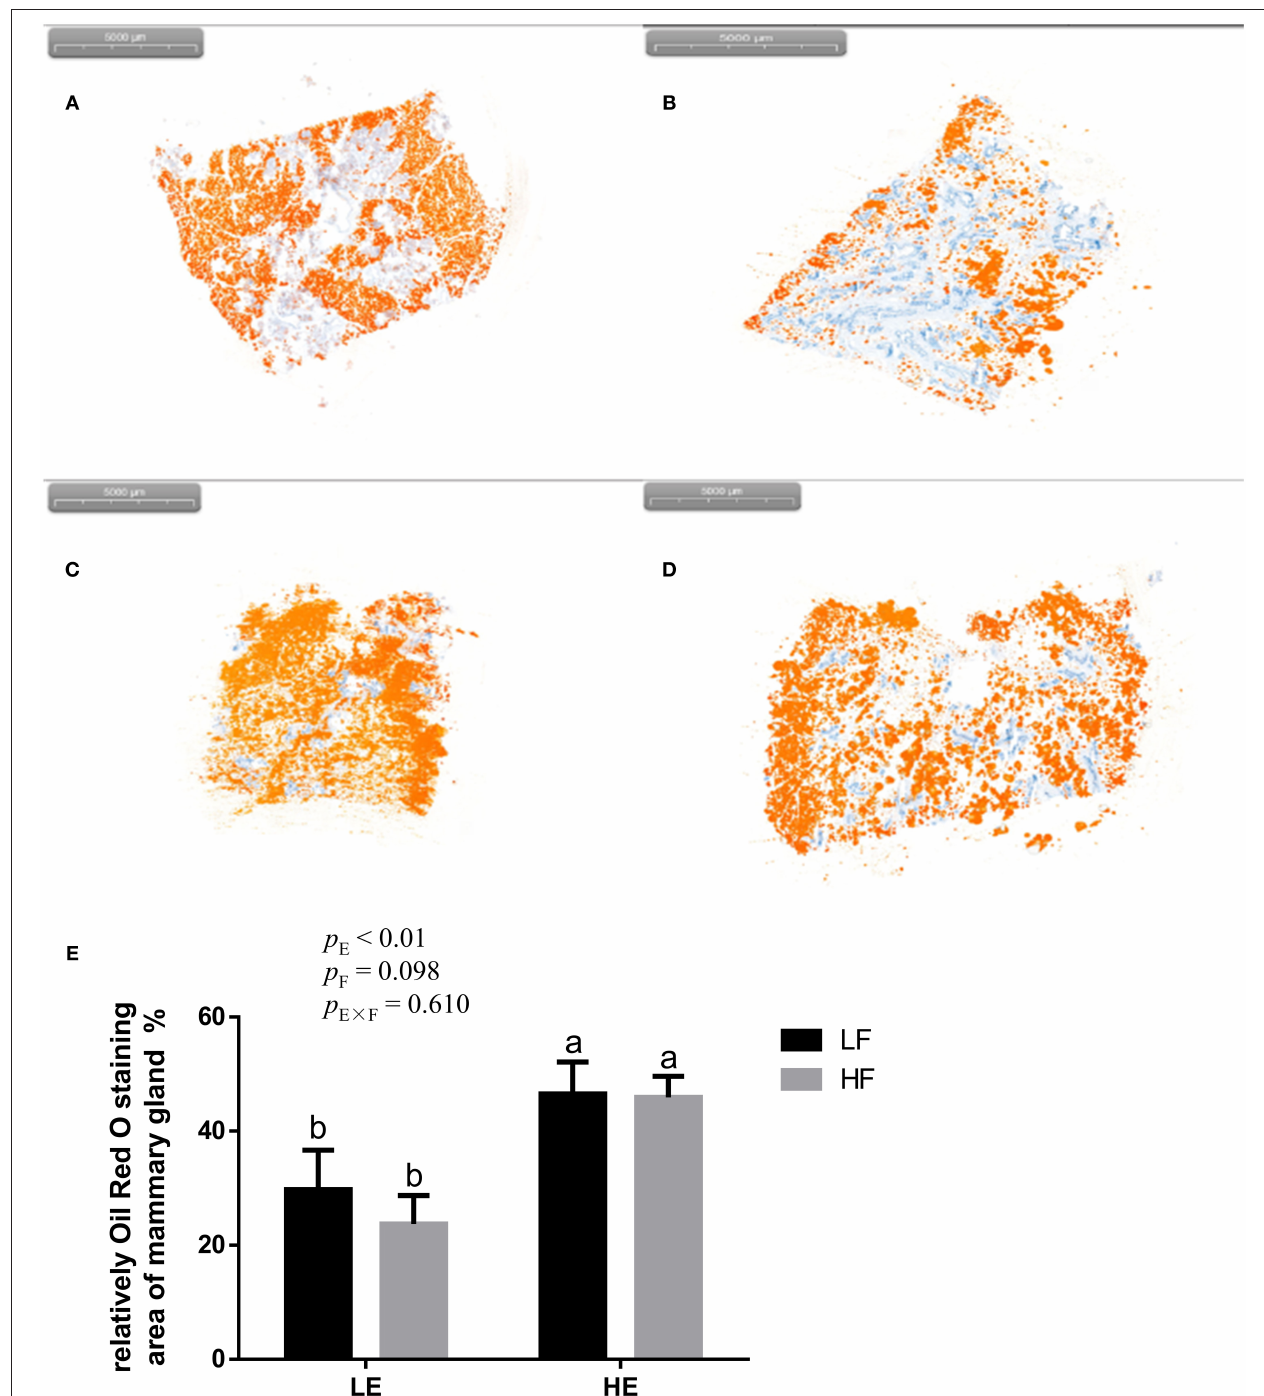
FIGURE 3 | Representative images (A–D) of red-staining sections of mammary gland in gilts and the effect of energy and fiber on the relatively oil red O–staining area of mammary gland in gilts (n = 8, E ). (A) Low-energy low-fiber group; (B) low-energy high fiber; (C) high-energy low-fiber group; (D) high-energy high-fiber group. LELF, low-energy low-fiber; LEHF, low-energy high-fiber; HELF, high-energy low-fiber; HEHF, high-energy high-fiber; E × F, energy and fiber interaction. a,b Means not sharing identical superscripts are significantly different ( p < 0.05).